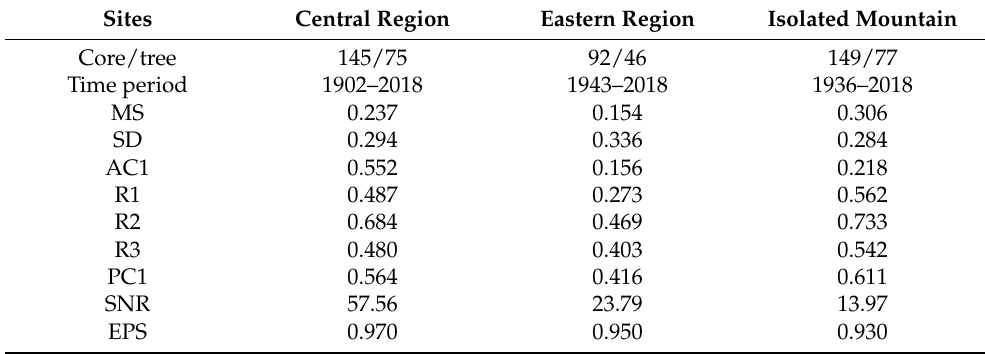
Table 2. Dendrochronological characteristics of chronologies for the Qinghai spruce. Sites Central Region Eastern Region Isolated Mountain